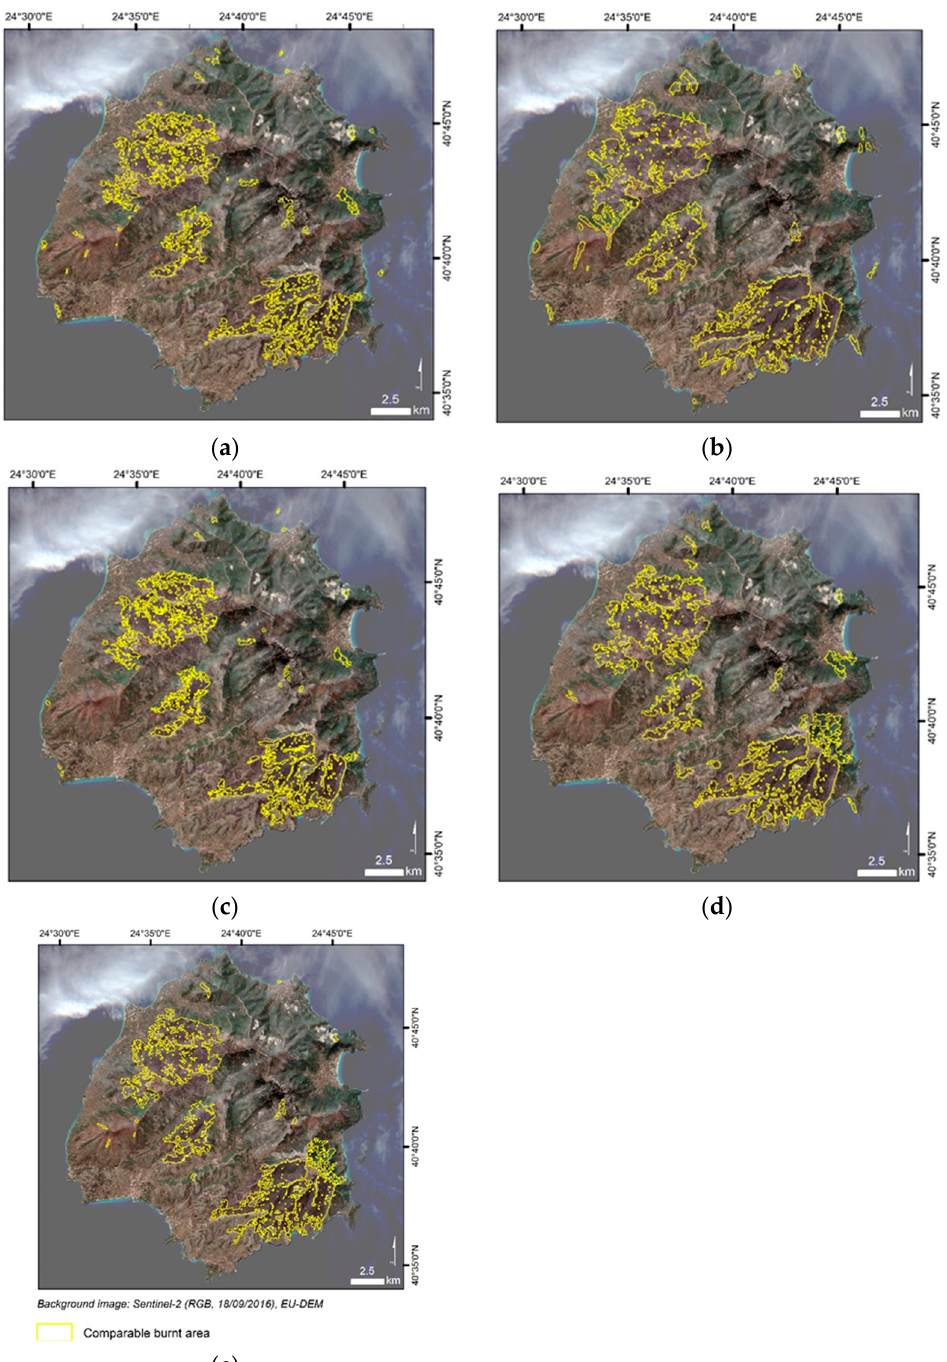
Figure 7. The comparable burnt area created using ( a ) ascending mode and VV polarization, ( b ) ascending mode and VH polarization, ( c ) ascending mode and double VV-VH polarization, ( d ) ascending and descending modes and VV polarization, and ( e ) ascending and descending modes and VH polarization.